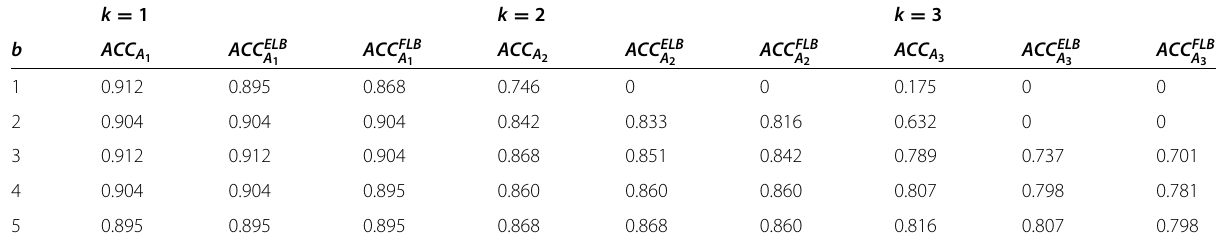
Table 8 Accuracy lower bound analysis on B REAST _C ANCER . h-FPF with | T | ≈ 300 and 8 leaves k = 1 k = 2 k =